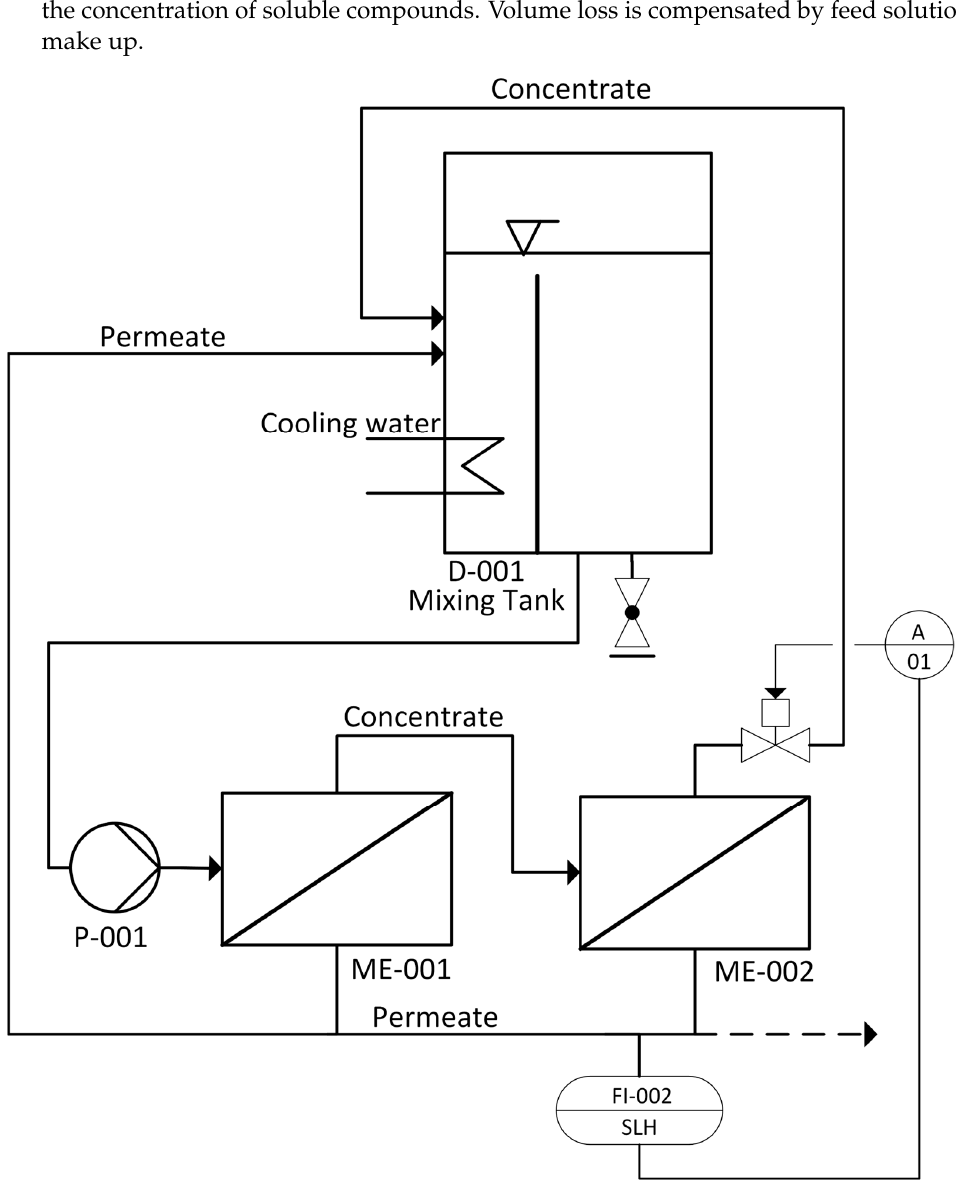
Figure 1. Process flow diagram of the ROLU used for reverse osmosis experiments on a lab scale. The concentration mode uses the dashed pipeline.